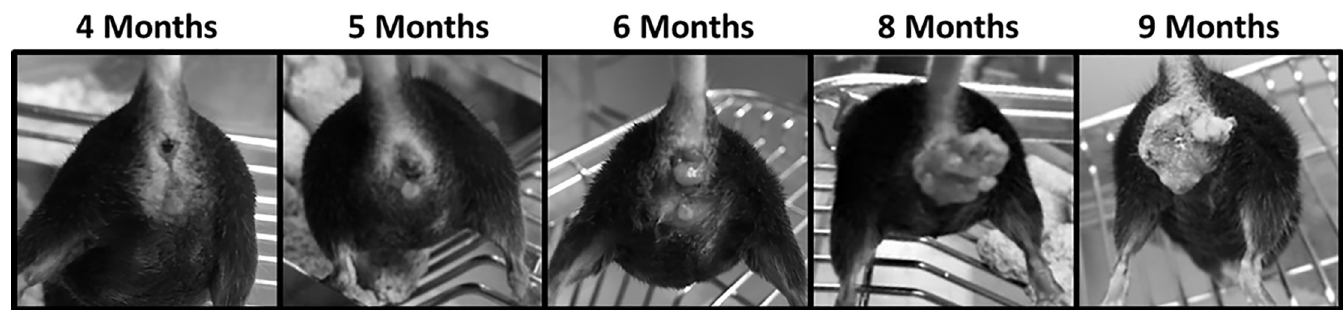
Fig 2. Anal tumor progression over time. In female KC mice, anal tumors are visible as an area of congestion at 4 months of age, with mild erythema around the anal region. By age 5 months, an anal tumor is generally evident. By 9 months of age, the anal tumors are significant in size. Despite the large size, the mice are able to maintain weight, consume food, and defecate normally. No mice experienced obstructive symptoms.